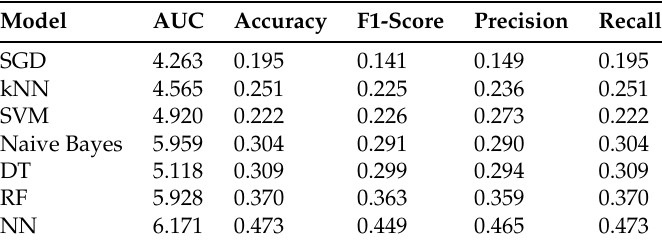
Table 10. Classification results using raw accelerometer, gyroscope, magnetometer, and light measurements.